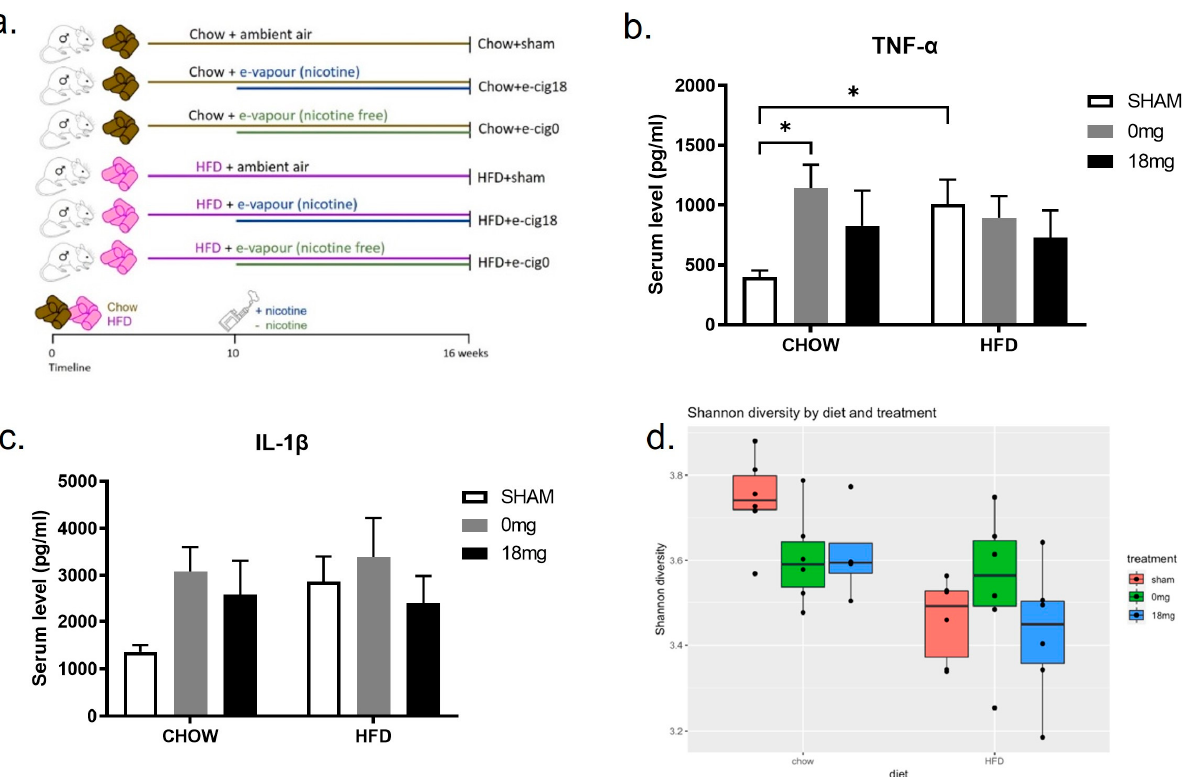
Figure 1. E ff ects of HFD- or chow-fed mice in the absence or presence of e-cigare tt e exposure (±nicotine). ( a ) Treatment timeline and study groups. Serum levels of proin fl ammatory cytokines ( b ) TNF- α and ( c ) IL-1 β . ( d ) Alpha diversity analysed in faeces. Results are expressed as mean ± S.E.M, n = 5–6. * p < 0.05. e-cig18: exposed to nicotine-containing e-vapour; e-cig0: exposed to nicotine-free e-vapour; HFD: high-fat diet; sham: exposed to ambient air.